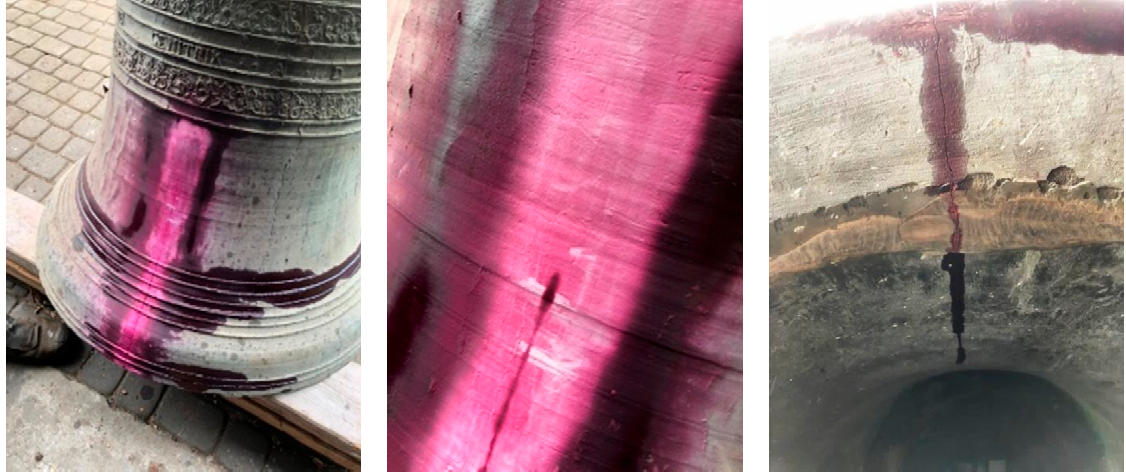
Figure 5. Penetration testing.